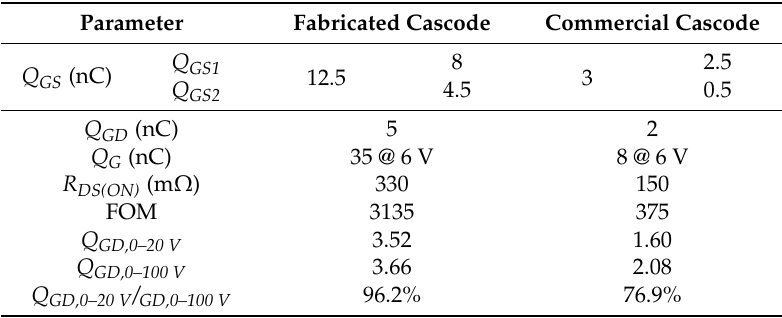
Figure of Merit (FOM) = ( Q GS2 + Q GD ) × R DS(ON) (10 − 12 Ω ×